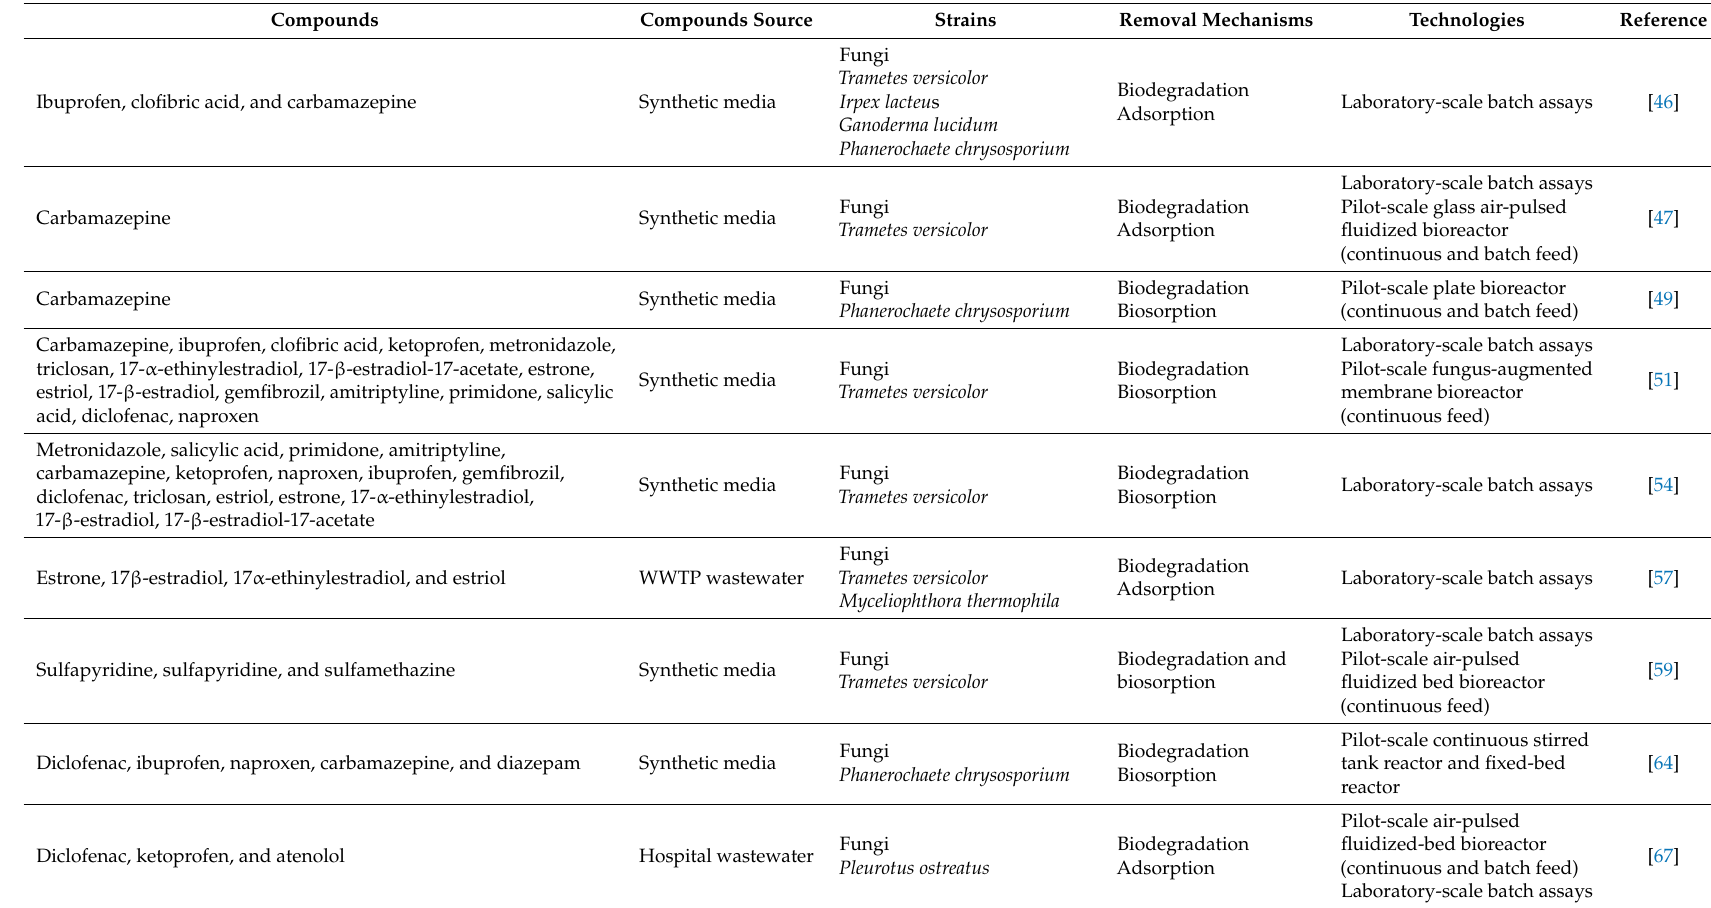
Table 2. Biosorption studies with fungi and algae for removal of